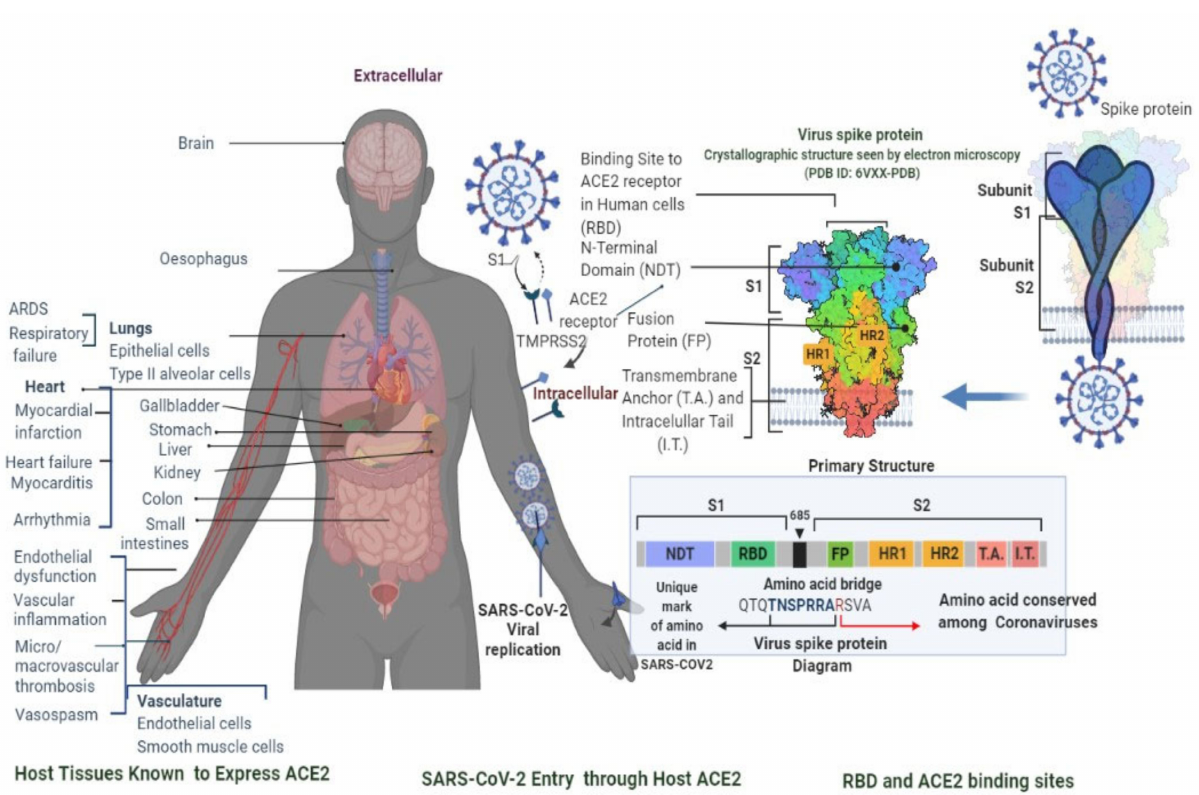
Figure 1. When an infected person releases the virus, it connects to ACE2 receptors on airway host cells and spreads. Targeting and invasion of ACE2 receptor-infected cells by SARS-CoV-2, as well as ACE2 receptor expression in human host tissues. SARS-CoV-2 S glycoprotein is made up of two subunits, S1 and S2, which are commonly depicted as a sword-like tip. The glycoprotein model from the Protein Data Bank (PDB) shows how subunits are arranged in several critical areas for the infectious process. An amino acid bridge connects proteins S1 and S2. This is vital information when considering virus targeting. Since it is essential for viral attachment, fusion, and invasion, the CoV-Spike (S) protein is a target for the creation of inhibitors. In both humans and bats, there is a close relationship between the RBD (receptor-binding domain) protein and the ACE2 receptor. In contrast to SARS-CoV RBD, SARS-CoV-2 RBD has a considerably higher affinity for binding to ACE2 receptors, which prevents either virus from attaching to or connecting to ACE2-expressing cells and transmitting infection to host cells. Randomisation of trials and at least one risk factor (heart disease, diabetes, etc.) are linked to worse illness